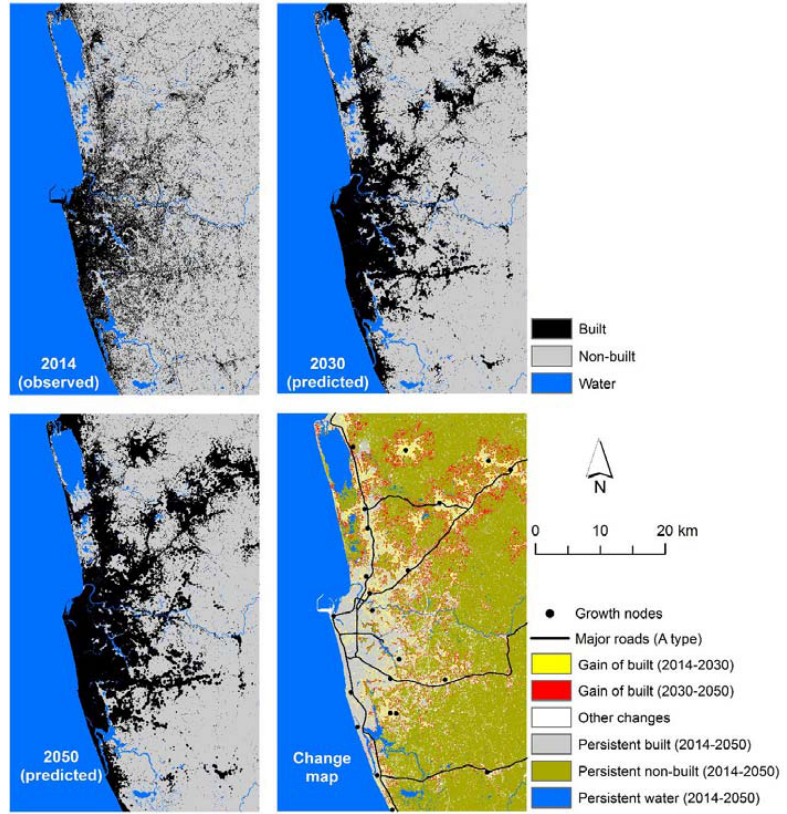
Figure 7. Observed (2014) and predicted (2030 and 2050) land-use/cover maps of CMA and the detected ULCs.